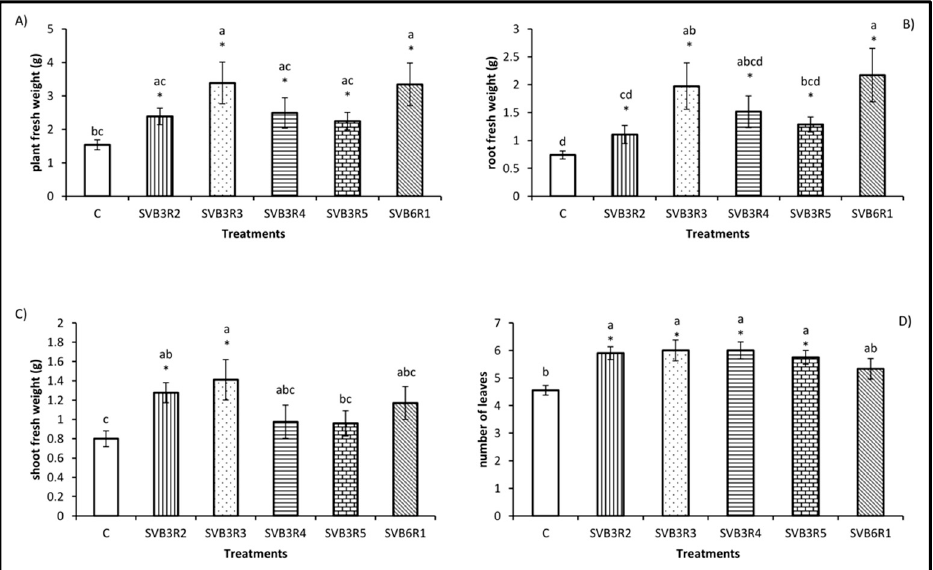
Figure 4. Effects of the selected bacterial strains on sorghum growth parameters (plant fresh weight, ( A ); root fresh weight, ( B ); shoot fresh weight, ( C ); and leaf number, ( D )). The values presented in